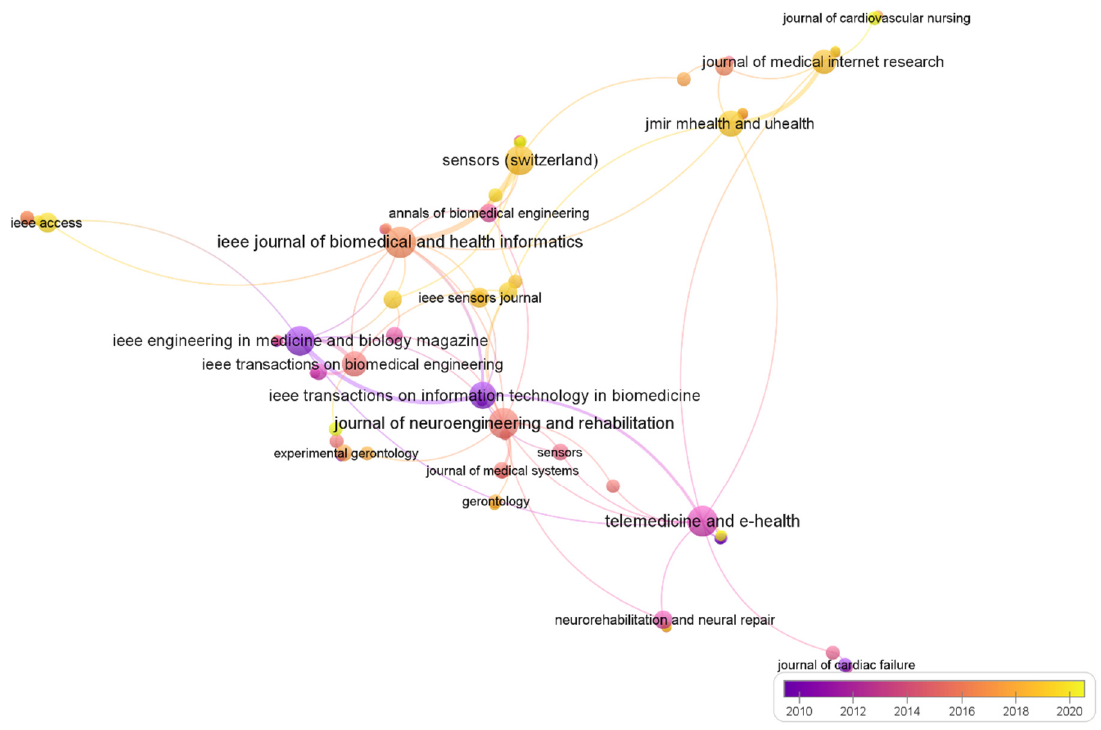
Figure 6. Cluster view of journals with higher link strength obtained with the VOSviewer tool.